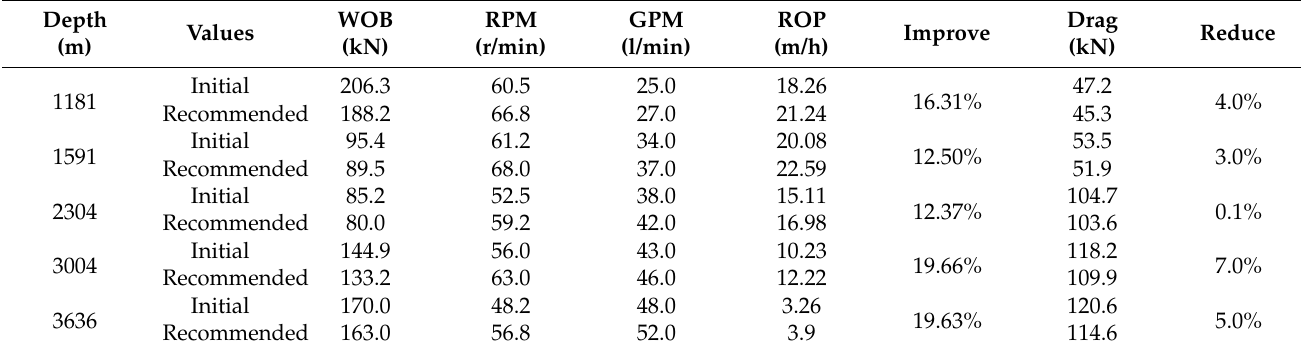
Table 6. The ROP increase and drag reduction effect at test